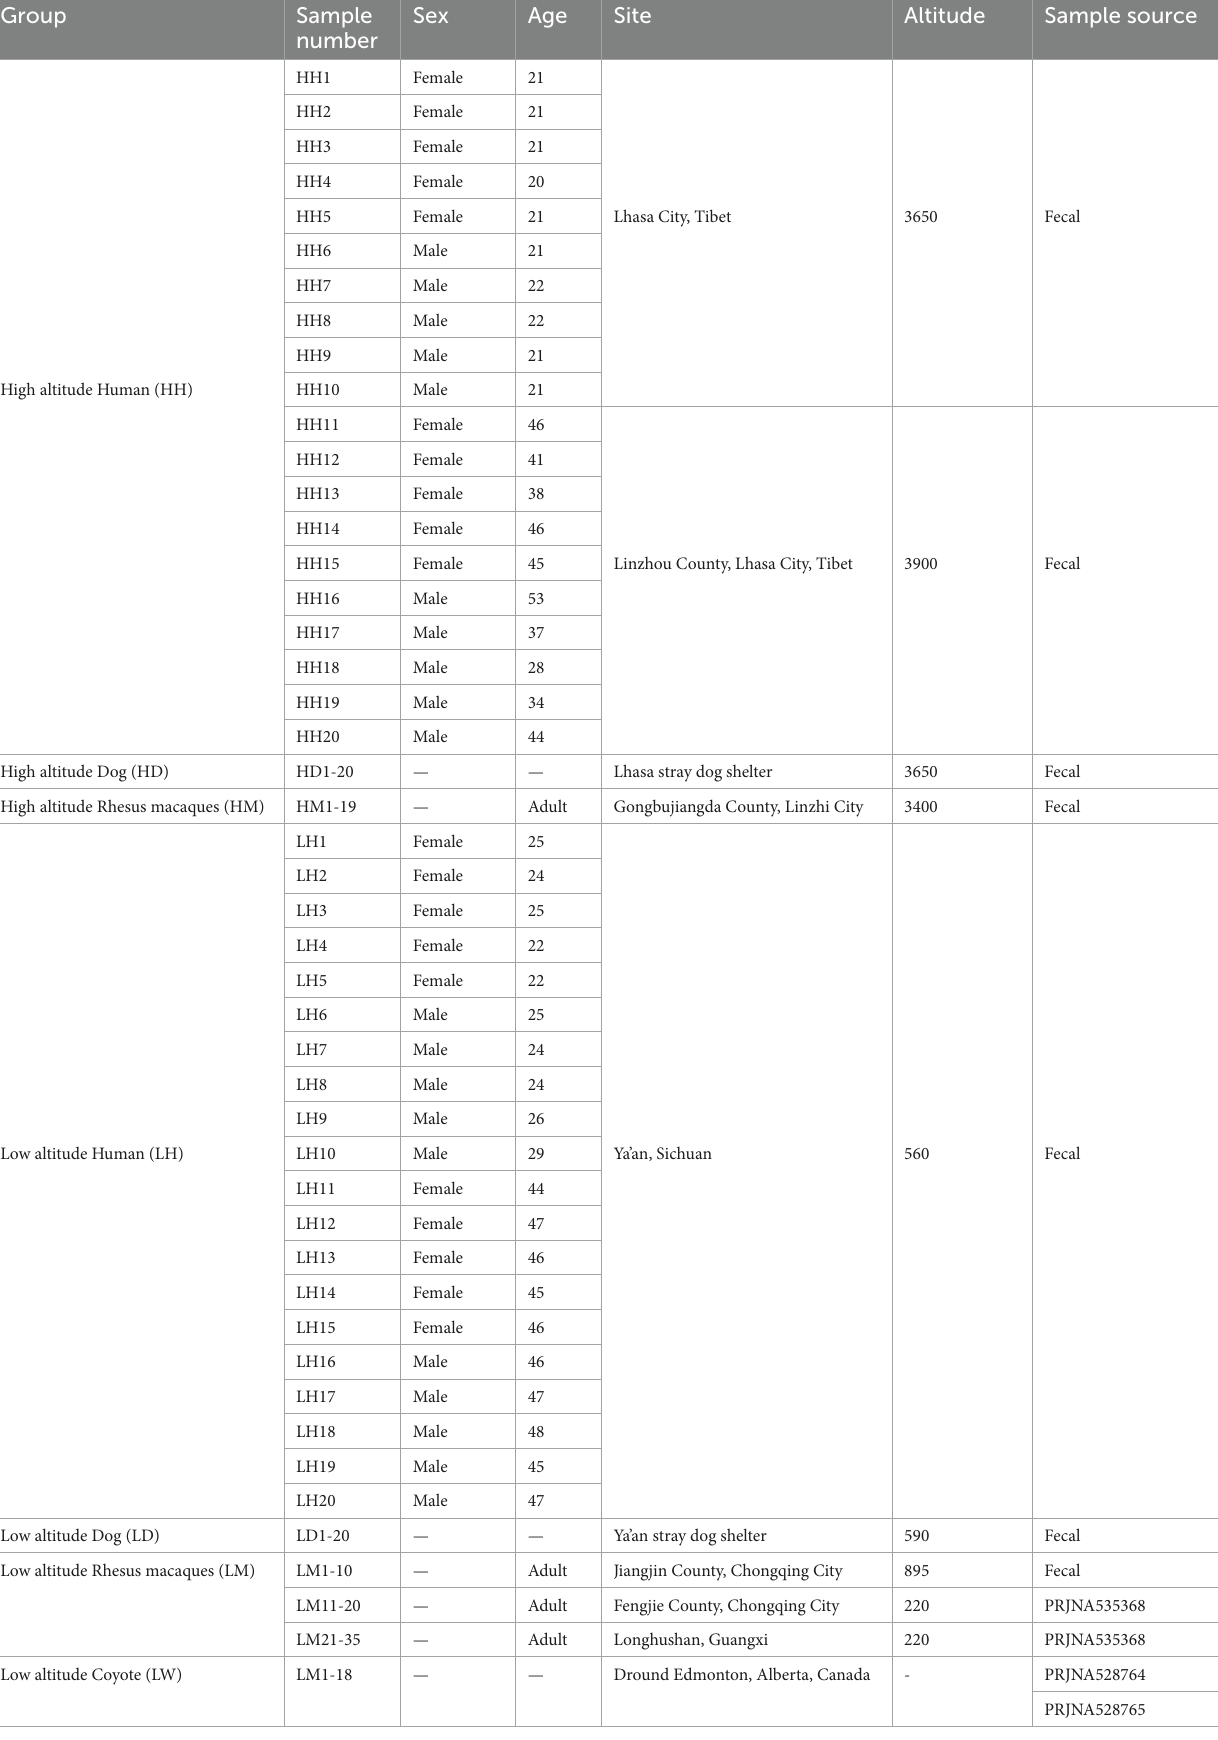
TABLE 1 Sampling information table.